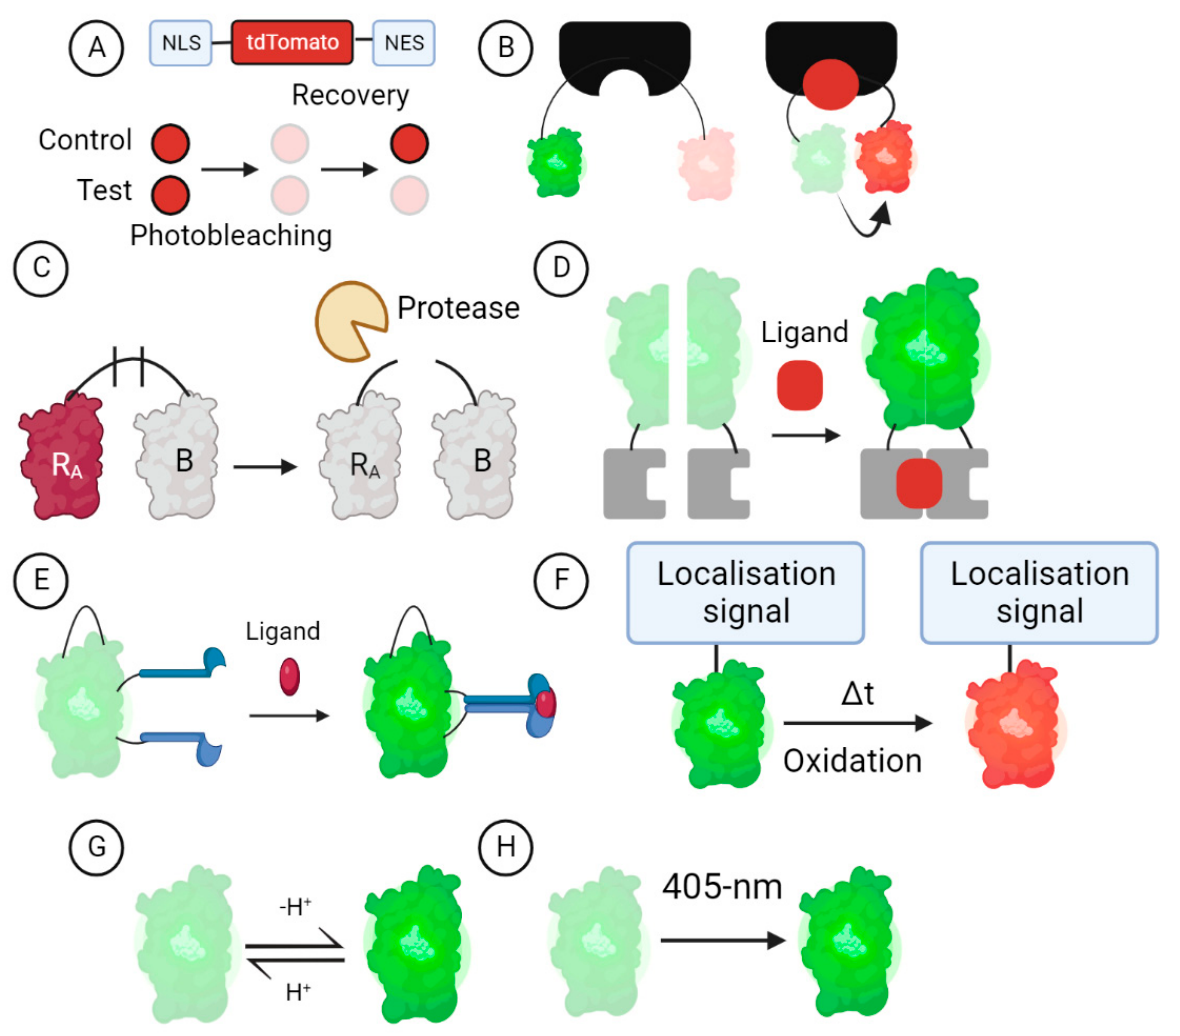
Figure 1. Eight different GEFB design concept examples. ( A ) Translocation of FP. ( B ) Fluorescence-resonance-energy-transfer-based biosensor. ( C ) Dimer-dependent GEFB. ( D ) Biomolecular fluorescence complementation. ( E ) A circularly permuted FP biosensor. ( F ) Oxidation-dependent fluorescent timer biosensor. ( G ) pH-sensitive FP. ( H ) Photo-transformable design. Each design is further elucidated in Sections 3.1–3.7.